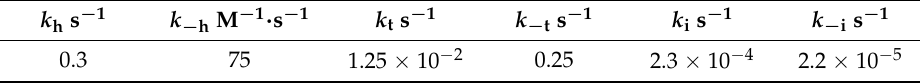
Table 4. Equilibrium constants of the compound 4 ′ ,7-dihydroxy-3-methoxyflavylium.